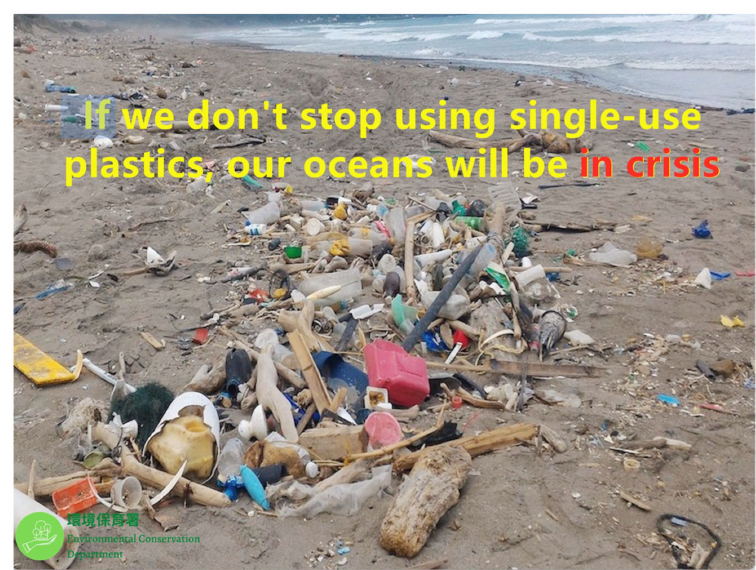
Figure A7. Example of condition 7: Loss * image * government.